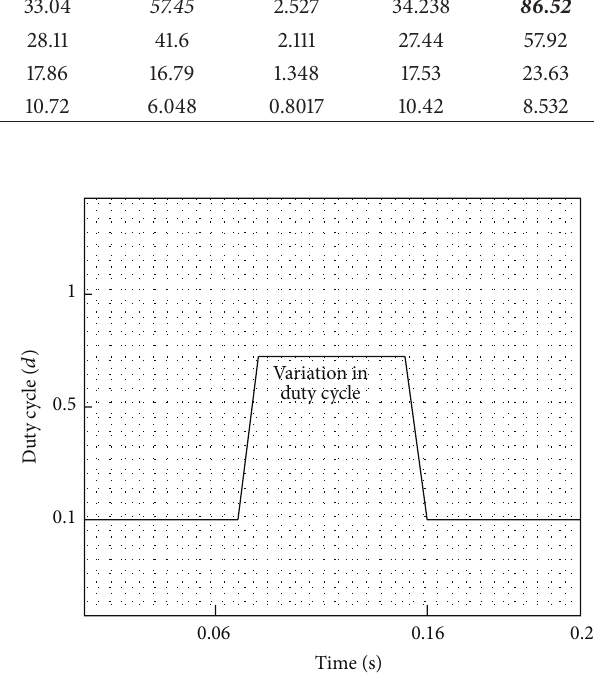
Figure 18: Variable irradiation with respect to time to observe the variation in duty cycle. Figure 19: Variation in duty cycle with respect to irradiations.